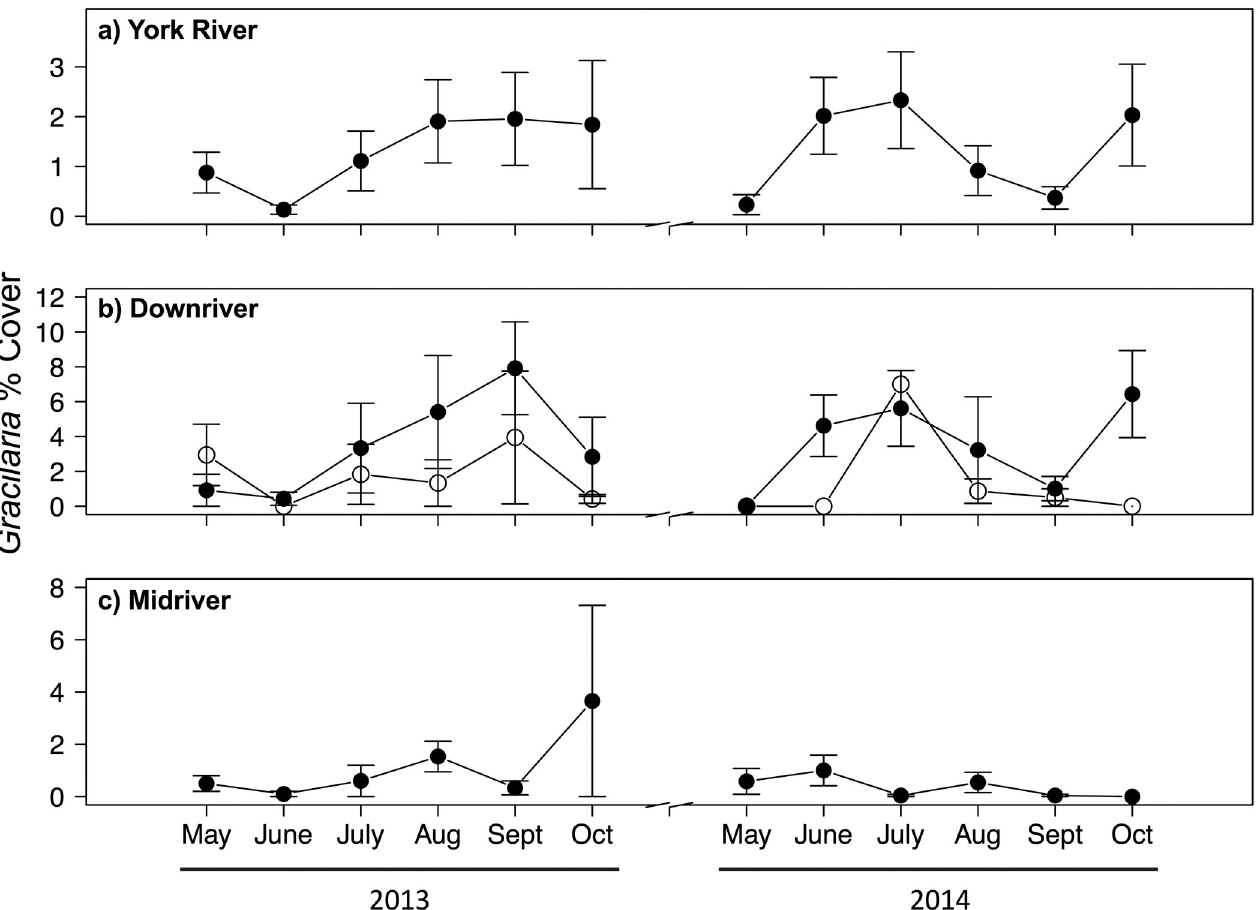
Fig 5. Mean Gracilaria vermiculophylla percent cover during 2013 and 2014 over: (a) the entire York River; (b) the downriver region, where base habitats are seagrass (filled) and unvegetated (open); and (c) midriver region. Gracilaria vermiculophylla was not observed upriver. Vertical bars represent 1 standard error of the mean. Note differing scales on